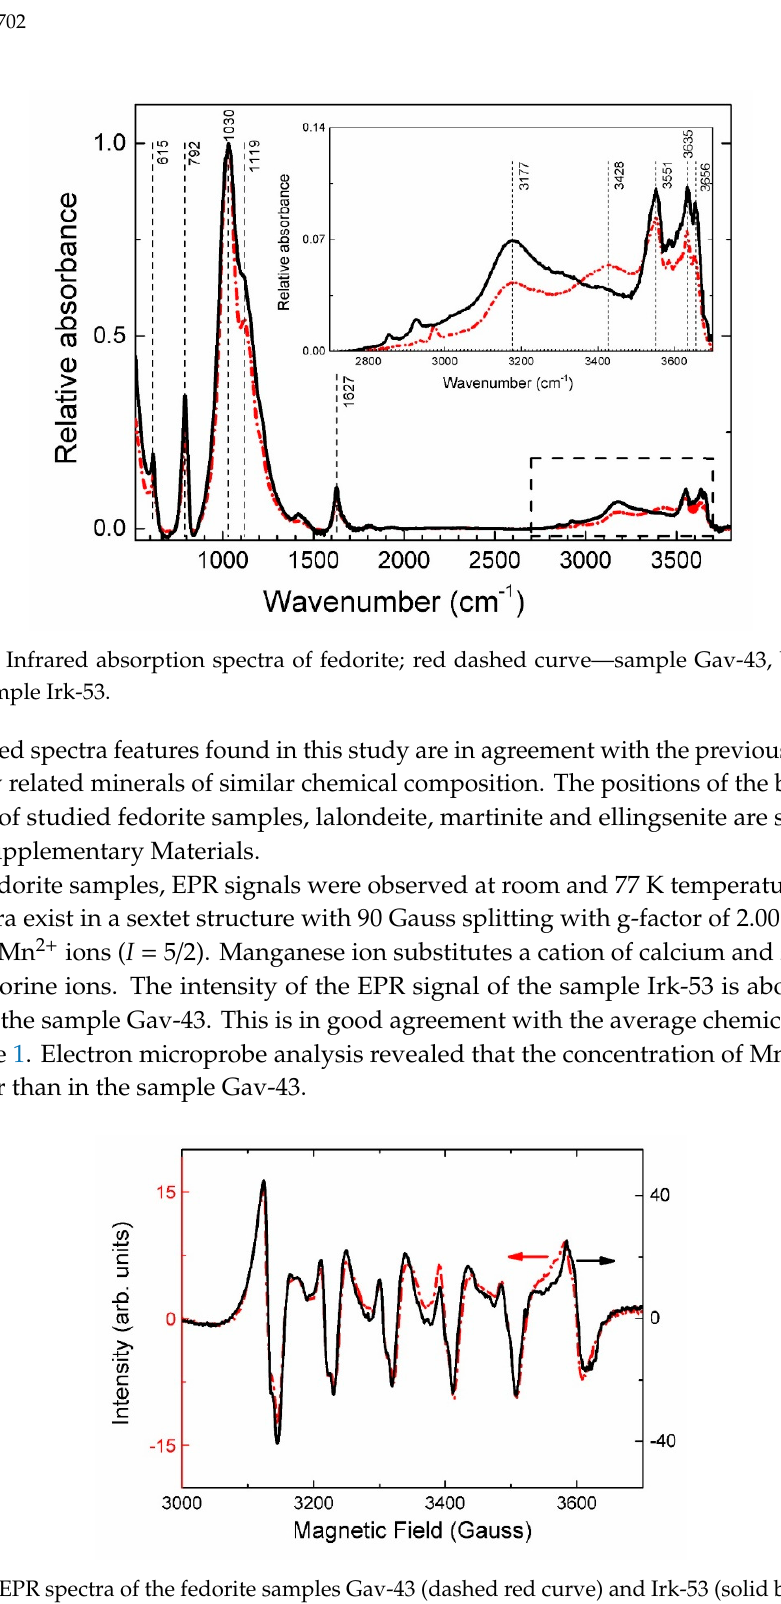
Figure 12. EPR spectra of the fedorite samples Gav-43 (dashed red curve) and Irk-53 (solid black curve) and measured at 77 K.